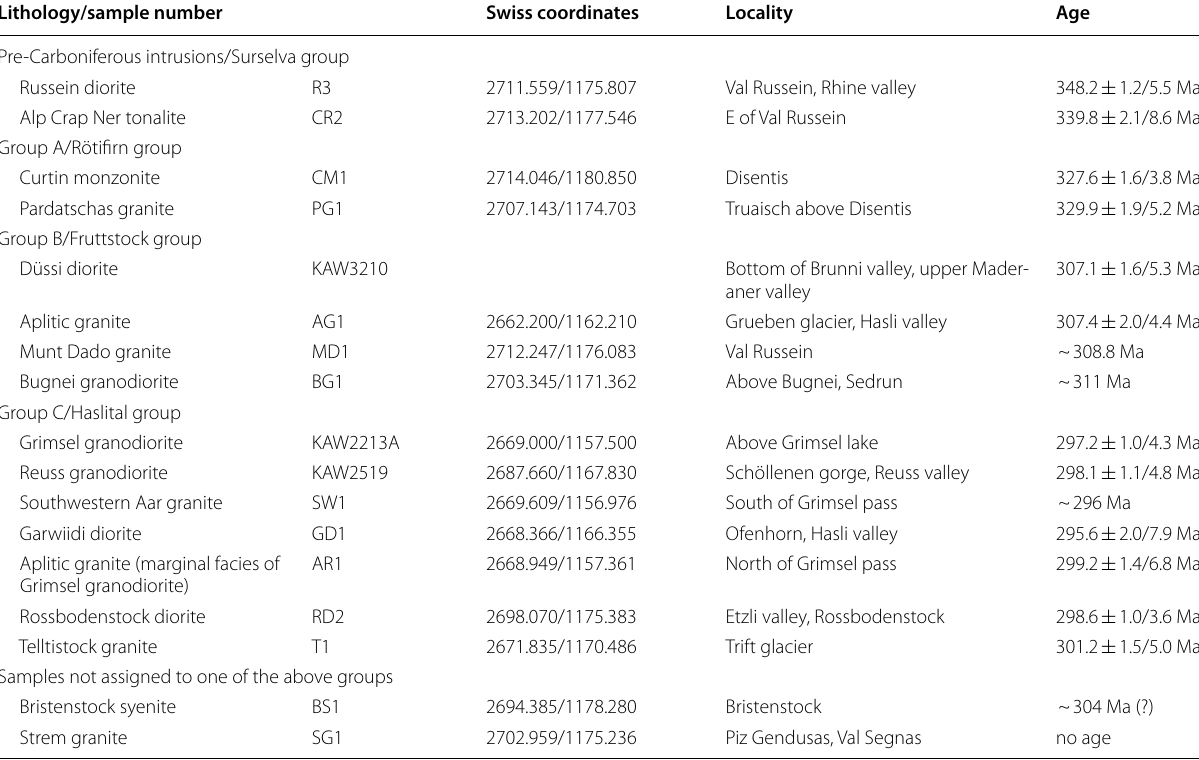
Table 1 Summary of samples localities and LA-ICP-MS ages Lithology/sample